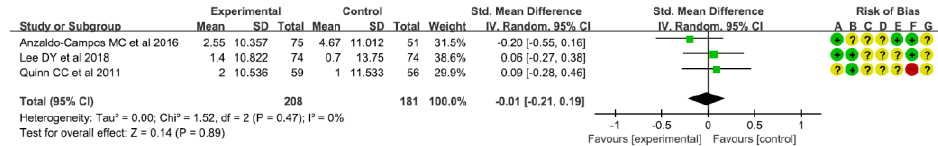
Figure 9. Forest plot for meta-analysis results on HDL-C [10,15,16].